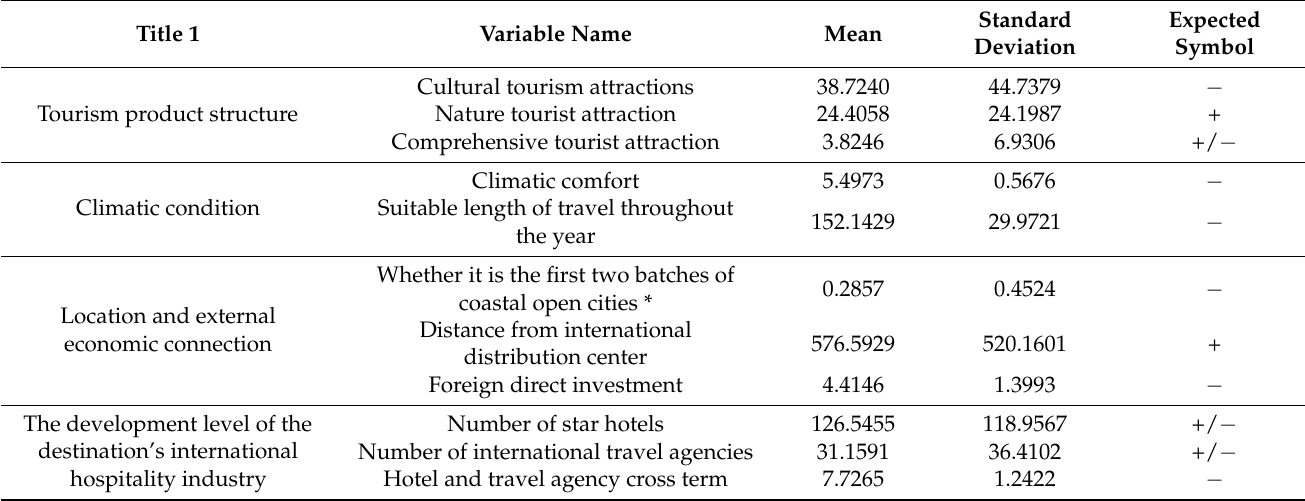
Table 1. Independent variables of tourism seasonal